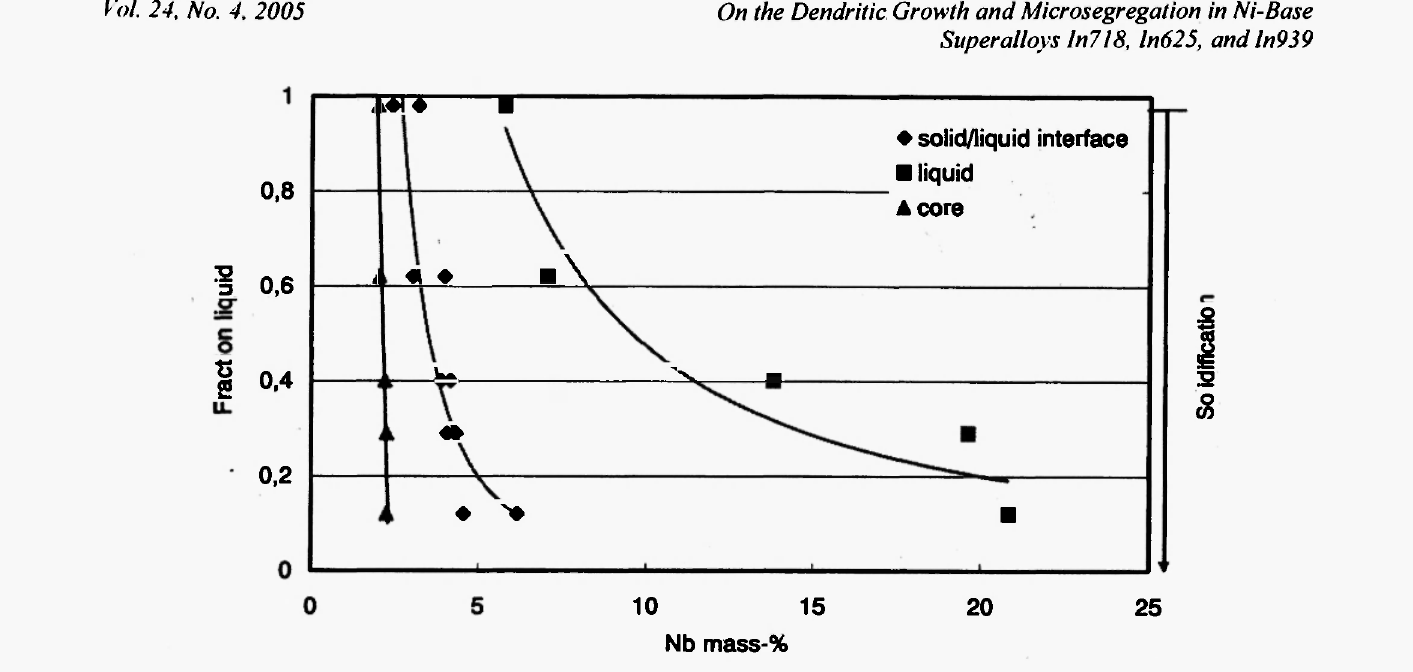
Fig. 15: IN718. Nb concentration in the solid (dendrite core), at the solid/liquid interface and in the liquid, as function of the fraction of liquid. Extraction rate v=10010" 6 m/s.